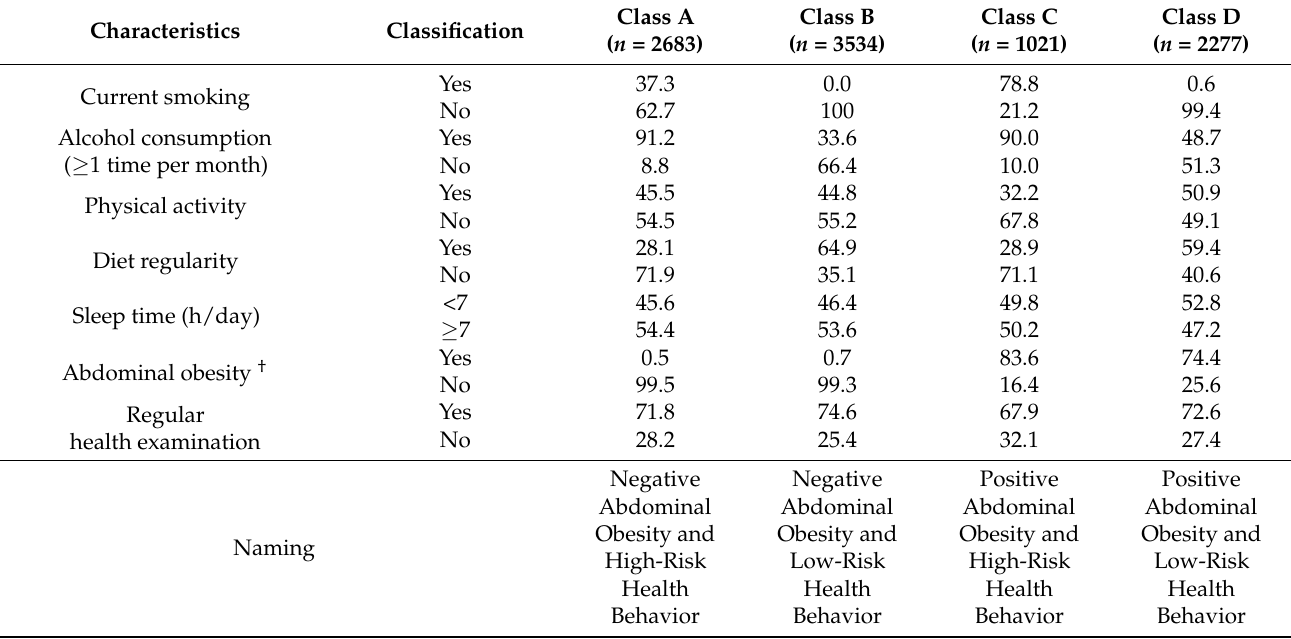
Table 2. Prevalence of health behaviors in all four class